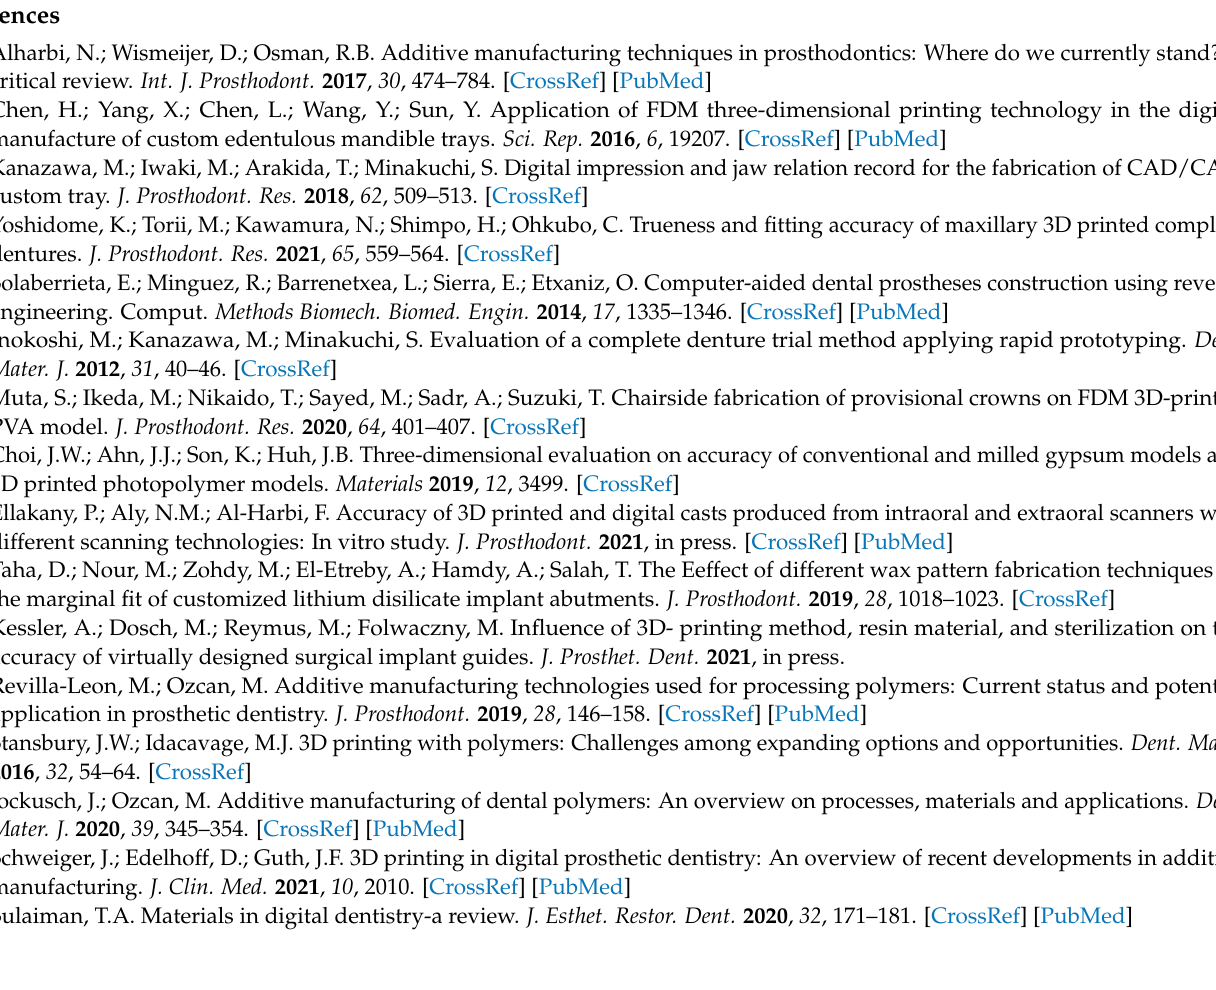
Figure A1. Photography of the 3D-printed crown set on the abutment tooth of the phantom model. The crown was fabricated using SLA 3D-printing and the PMMA-based resin P30E56M14. The printed crown surface was partially ground and polished to adjust the abutment